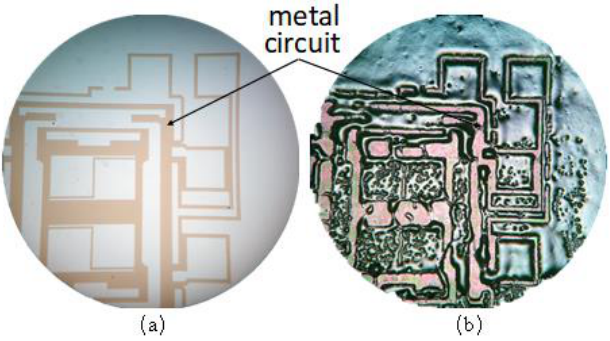
Figure 7. Pre-sintering effect of glass slurry on large-area metal circuit: ( a ) metal circuit; ( b ) morphology of hot-melt glass.